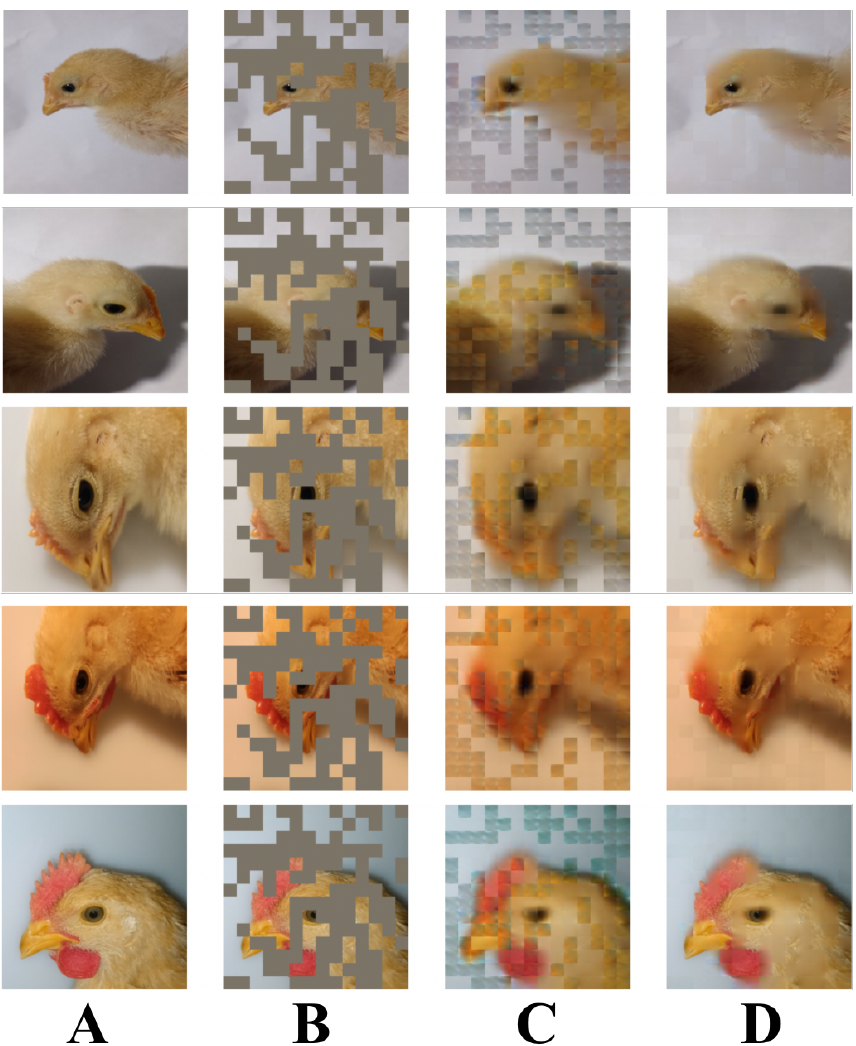
Figure 5. The data-generating effect of MAE. ( A ) Original image series; ( B ) masked image series; ( C ) half-reconstructed image series; ( D ) reconstructed unmasked image